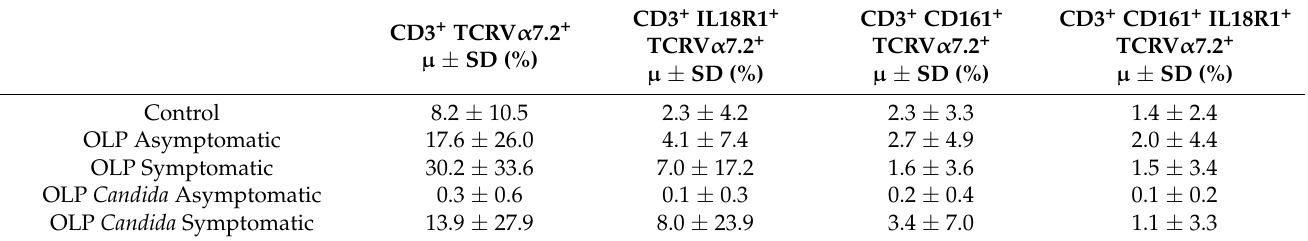
Table 3. Mean and standard deviation of MAIT phenotypes as a percentage of the total CD3 popula- tion for the 5 groups presented using the raw